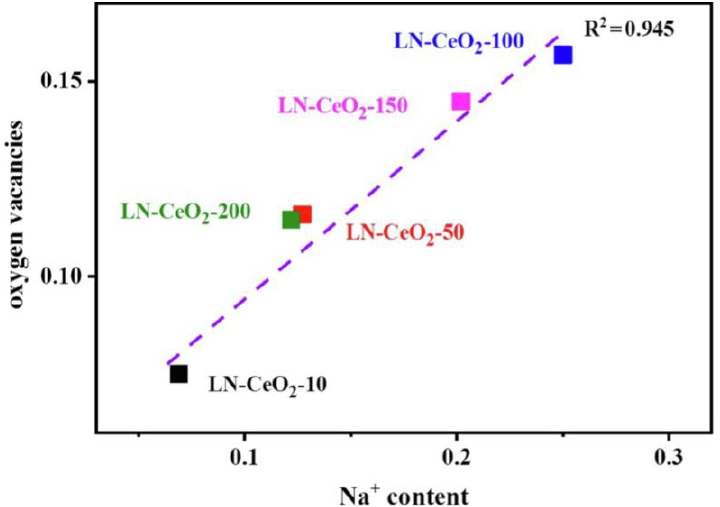
Figure 16. Relationship between oxygen vacancies concentration and Na content in ceria catalysts prepared with liquid nitrogen (LN-CeO 2 ). Reproduced with permission from Ref. [167]. Copyright © 2022, Elsevier.